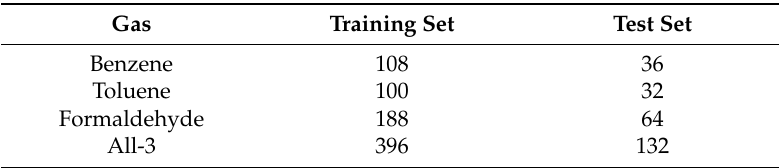
Table 3. Amount of samples in training set and test